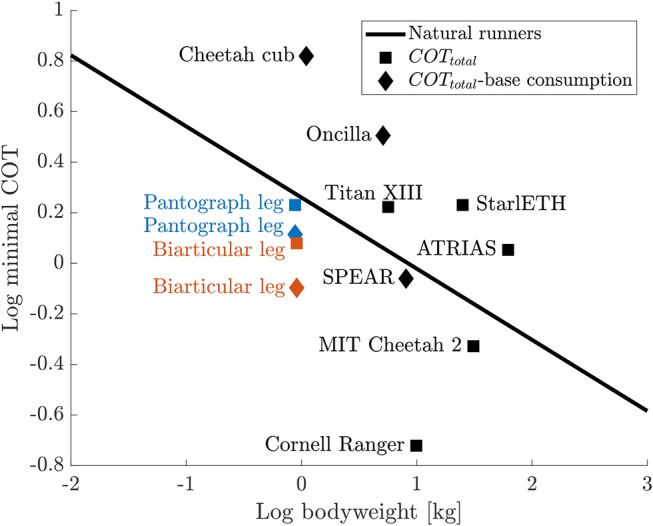
COT comparison for a selection of legged robots (Spröwitz et al., 2013, 2018; Bhounsule et al., 2014; Hutter et al., 2014; Renjewski et al., 2015; Kitano et al., 2016; Park et al., 2017; Liu et al., 2018) compared to the regression for animal runners from Tucker (1975) that shows a linear regression for the minimal COT from various running animals. Total COT values are shown as squares, COT values where base consumption (communication, electronics, etc.) is substracted, are shown as diamonds. The COT for the biarticular leg is 64% of the COT of a natural runner with the same weight. All COT values are listed in the Supplementary Material.